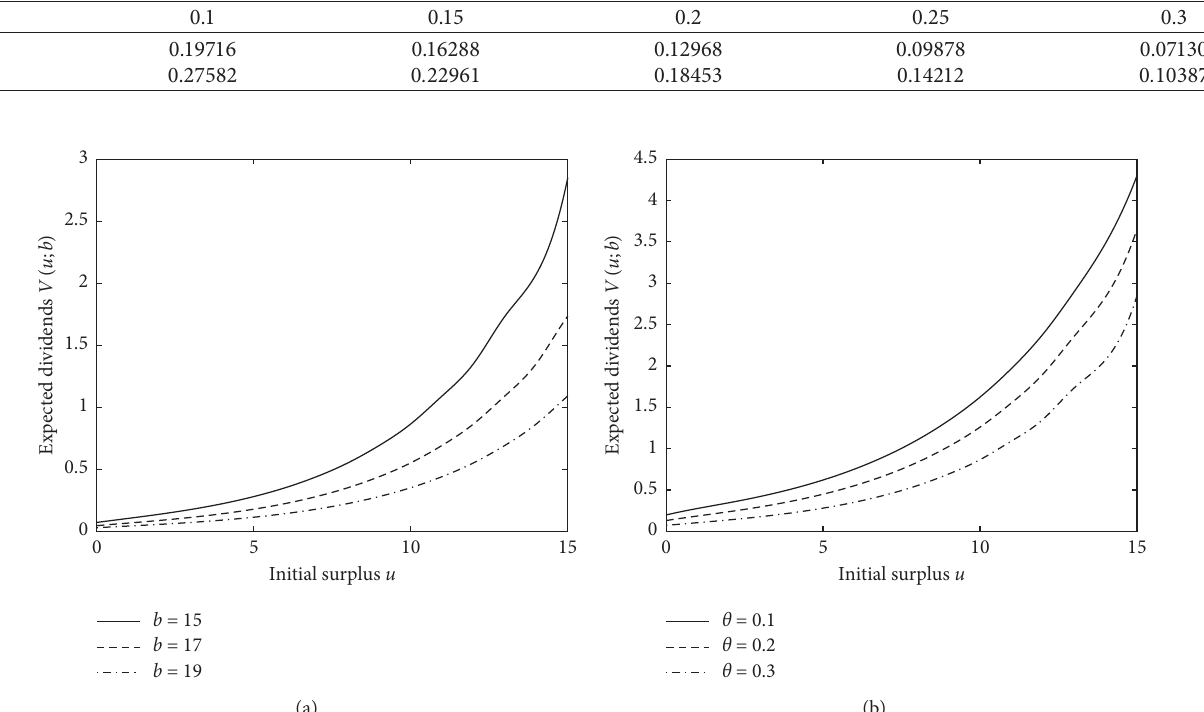
Table 4: Numerical results of α